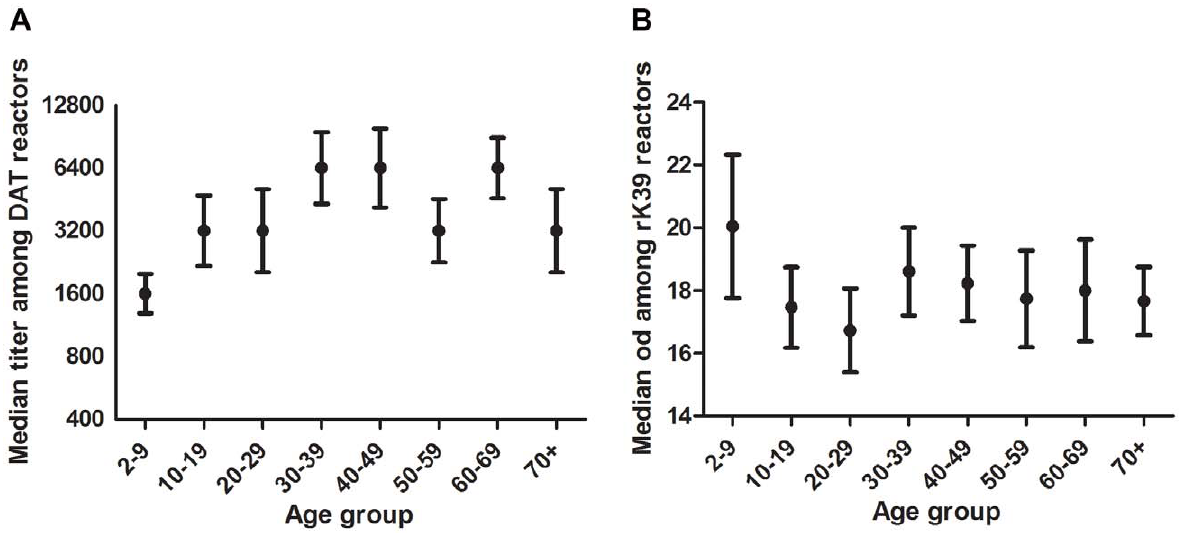
Figure 3. Median titer of positive DAT (left) or rK39 (right) tests by age. Among individuals who had a positive DAT response over or equal to 1:1600 or a positive rK39 response over or equal to 14 pp, the median DAT titer (left) or rK39 pp (right) plus 95% confidence intervals are plotted for each age group.